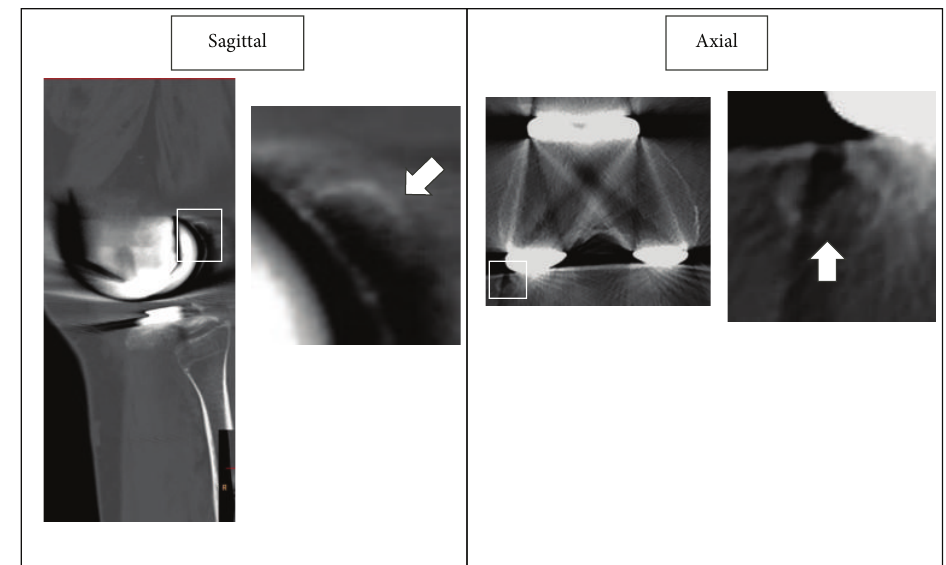
Figure 3: Position of the femoral component and the fabella; the white arrow identifies the